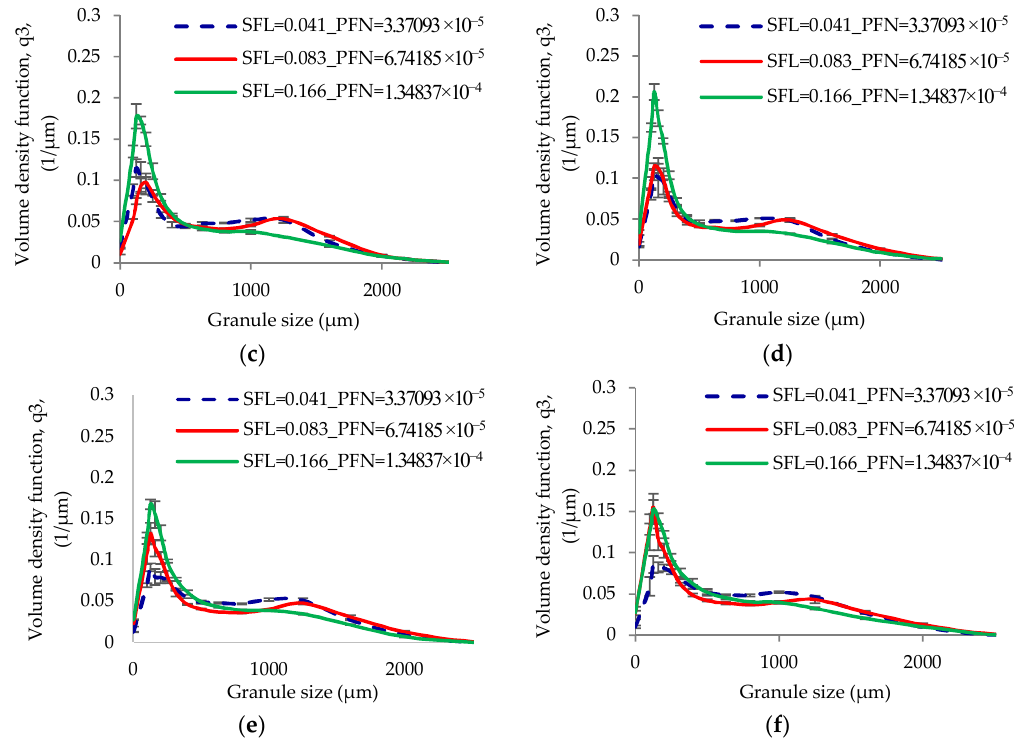
Figure 17. Granule size distribution of MCC (L/S 1) at different SFL–PFN at varying screw speed. ( a ) 150 rpm; ( b ) 250 rpm; ( c ) 400 rpm; ( d ) 500 rpm; ( e ) 750 rpm; and ( f ) 1000 rpm.